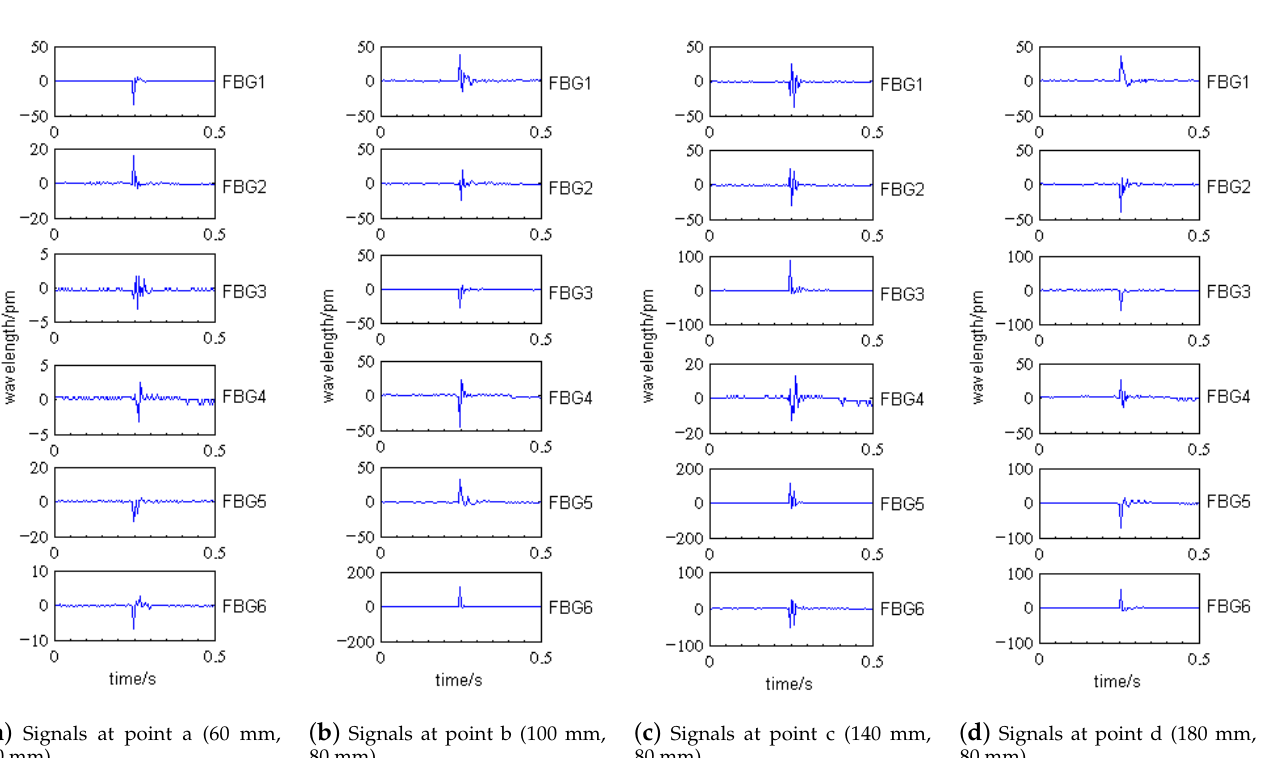
Figure 9. Signals at impact points a–d under 1